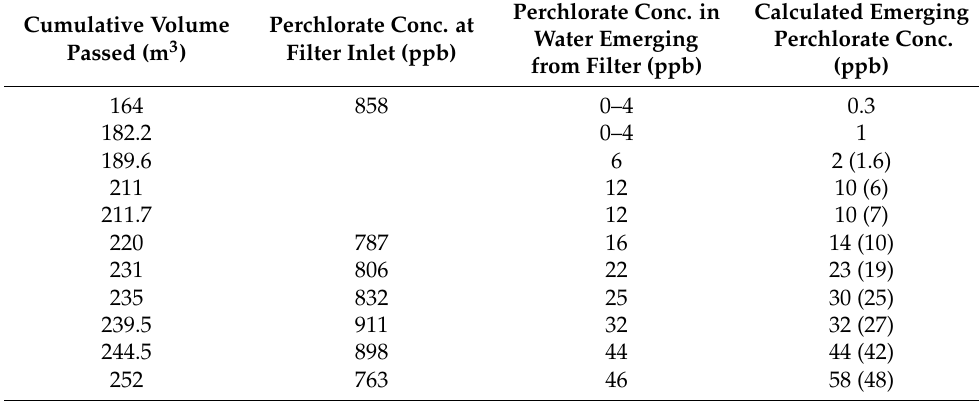
Table 6. Summary of a pilot experiment for perchlorate removal from. Water at a closed well in Yashresh a